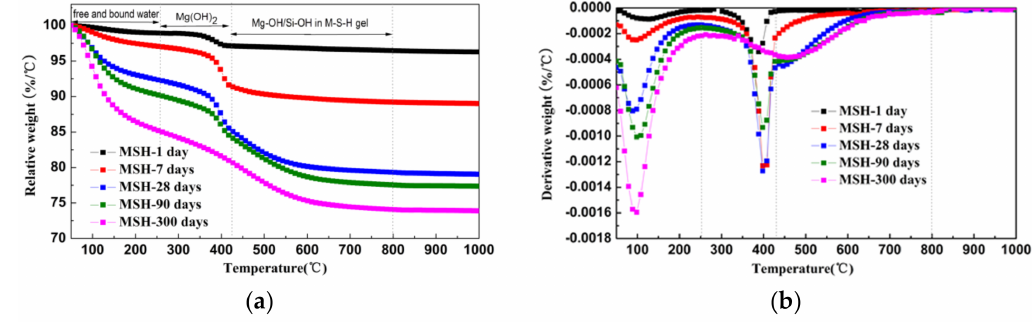
Figure 2. ( a ) Thermogravimetric (TG) and ( b ) Derivative weight curves (DTG) data for MSH samples cured for times up to 300 days.